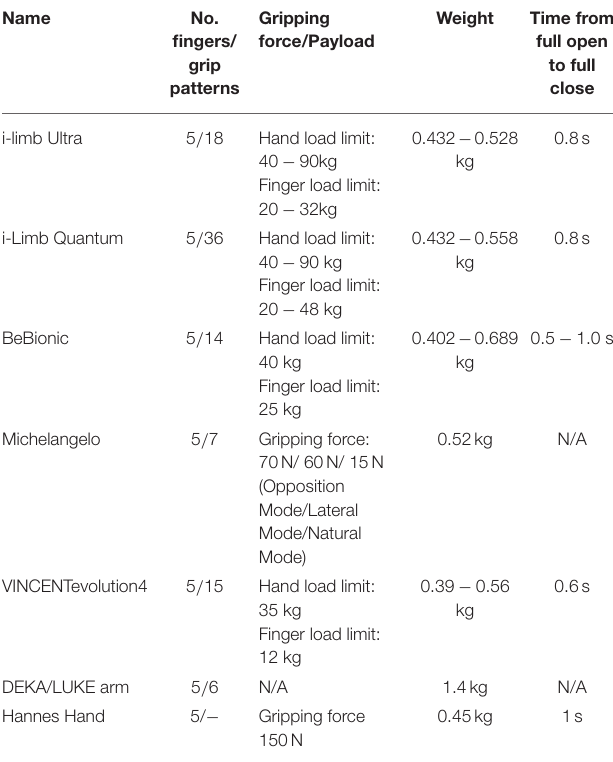
TABLE 2 | The technical details of the prosthetic